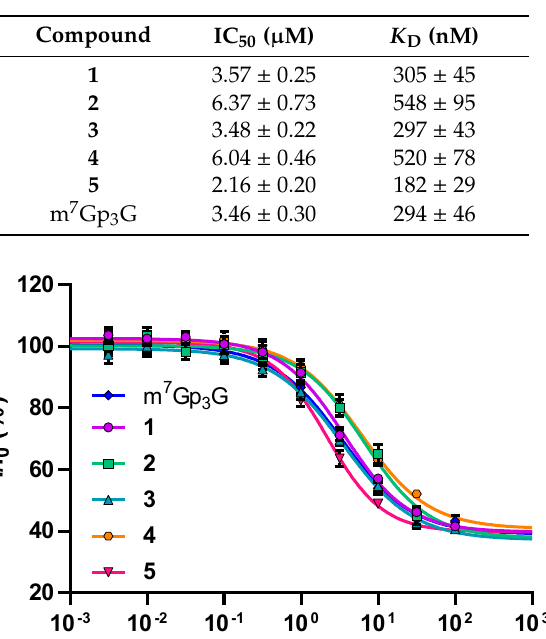
Table 1. IC 50 and K D values determined at 30 °C for the binding affinity for murine eIF4E. The IC 50 values were determined from the data shown in Figure 2. The K D values were calculated from the IC 50 values using a previously reported equation [33].